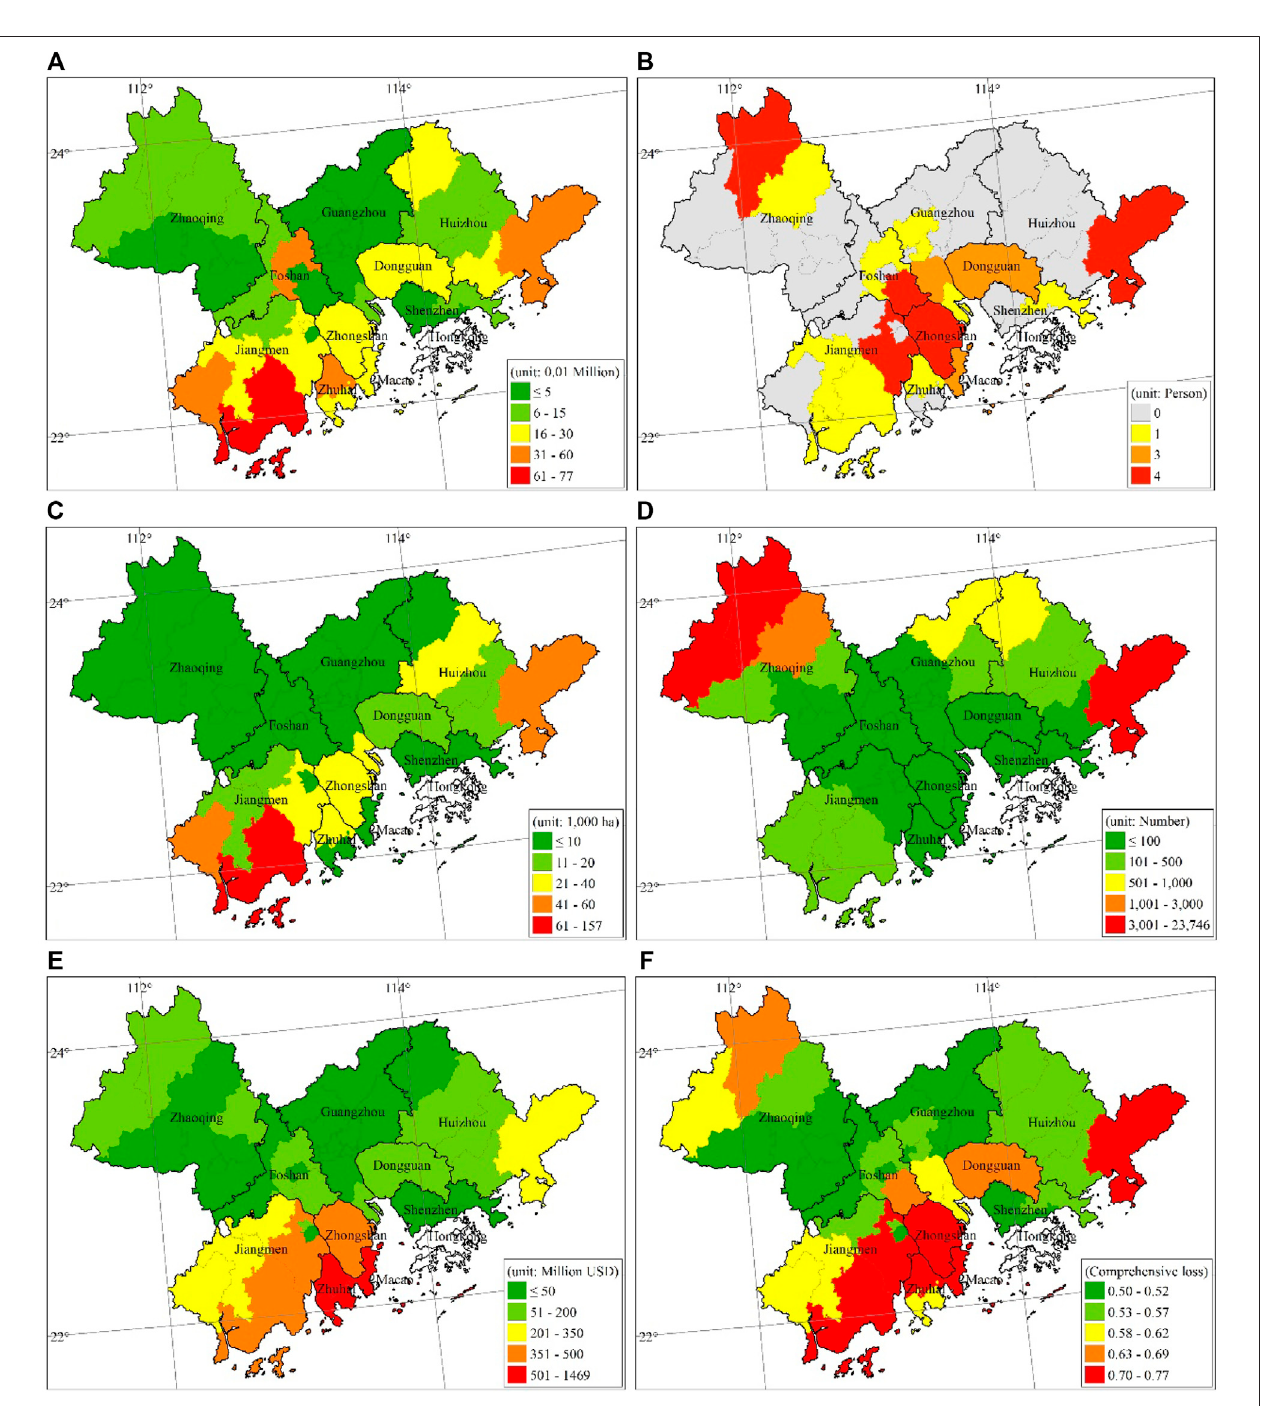
FIGURE 10 | (A) Disaster-affected population, (B) casualties and missing persons, (C) disaster-affected crop area, (D) collapsed buildings, (E) direct economic losses, and (F) comprehensive loss caused by typhoons in the GBA from 2009 to